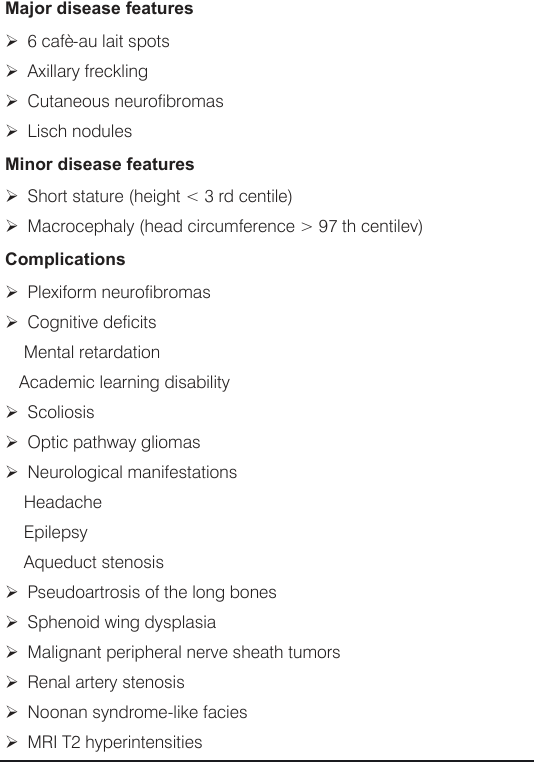
Table 2. Diagnostic criteria for